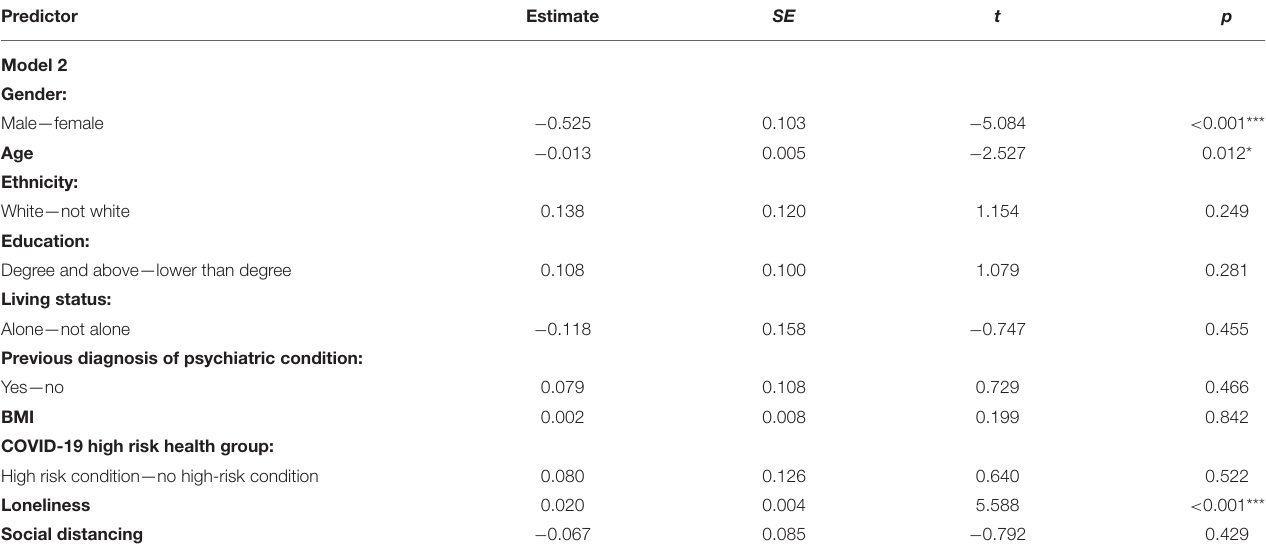
TABLE 4 | Results of multiple linear regression on change in anxiety. Predictor Estimate SE t p Model